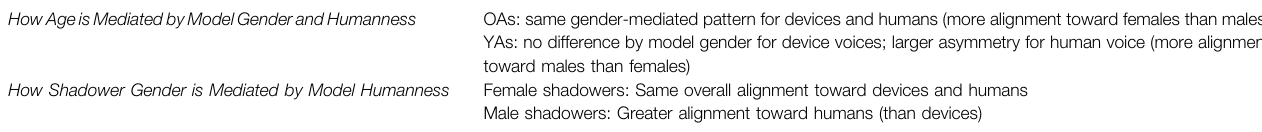
TABLE 2 | Summary of AXB similarity results. OAs: same gender-mediated pattern for devices and humans (more alignment toward females than males) YAs: no difference by model gender for device voices; larger asymmetry for human voice (more alignment toward males than females) How Shadower Gender is Mediated by Model